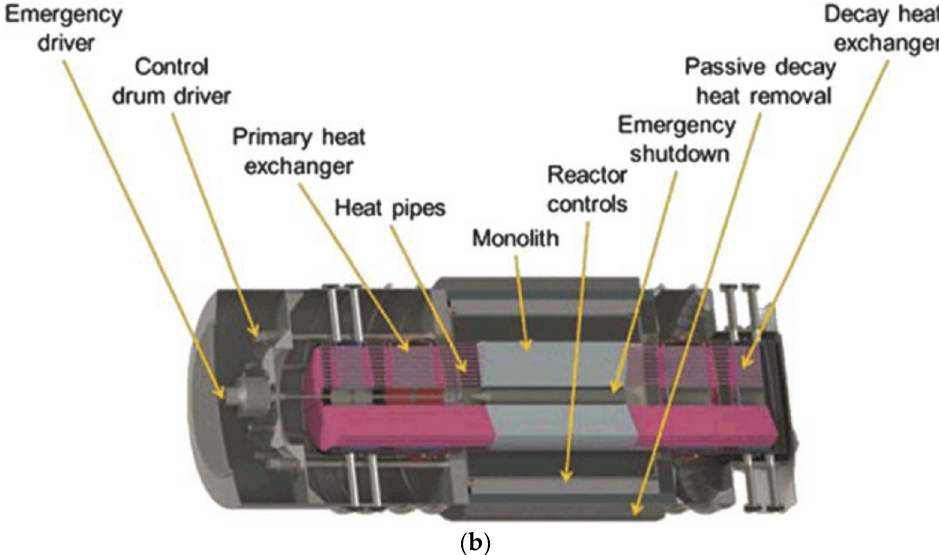
Figure 1. ( a ) eVinci reactor encapsulated in protective canisters [19]. ( b ) A crosssection showing the components of the eVinci reactor [22].